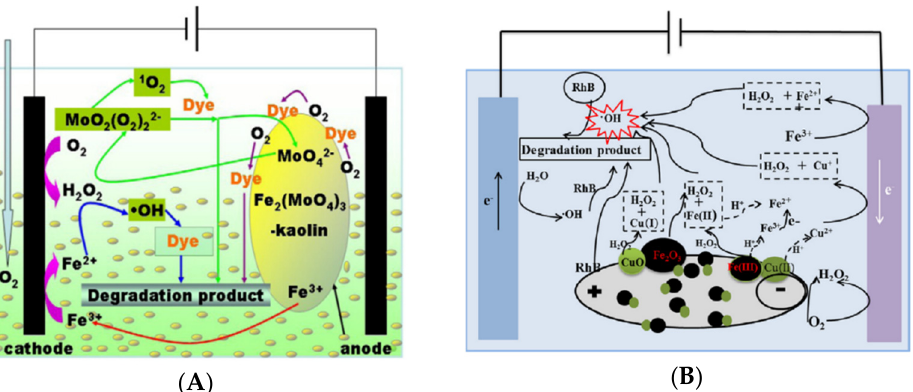
Figure 7. Scheme of three-dimensional electrochemical reactor using kaolin impregnated with ( A ) Fe 2 (MoO 4 ) 3 [69] ( B ) α -Fe 2 O 3 and CuO [70] as a heterogeneous catalyst for removal of dye molecules along with the proposed pseudo-heterogeneous mechanism for degradation of pollutants. Reprinted from [69,70] with permission from Elsevier (License Numbers 5172360390748 and 5172360545687).